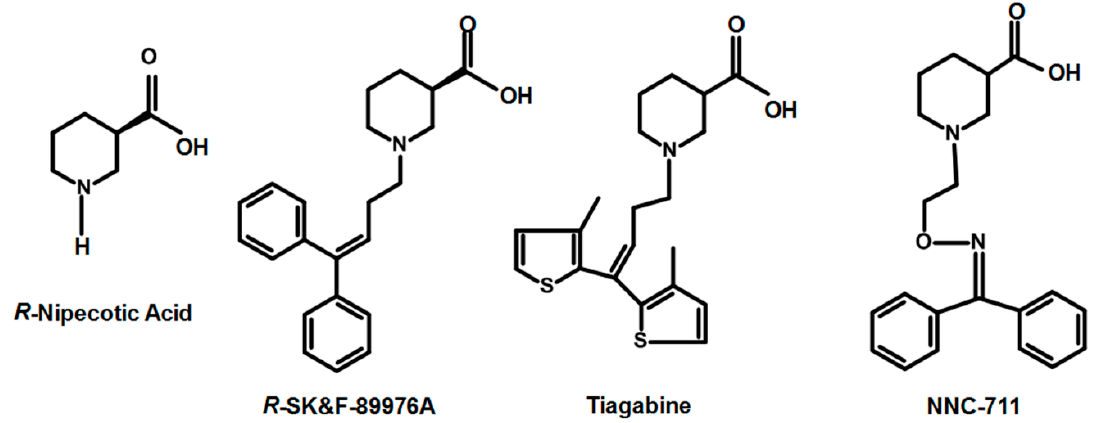
Figure 1. Chemical structures of well-known inhibitors of the human gamma aminobutyric acid transporter subtype 1 (hGAT1).